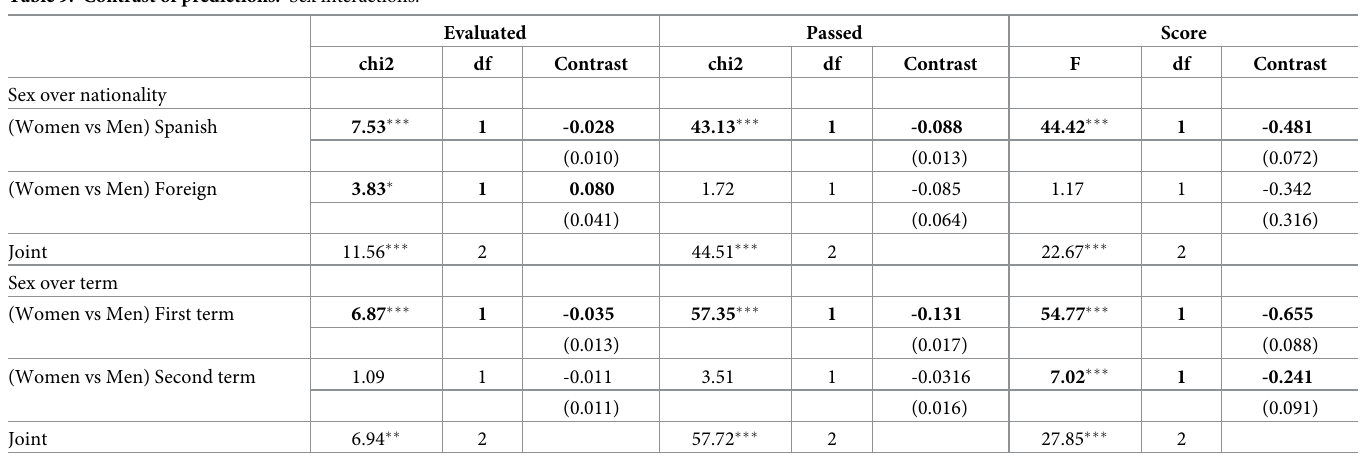
Table 9. Contrast of predictions. Sex